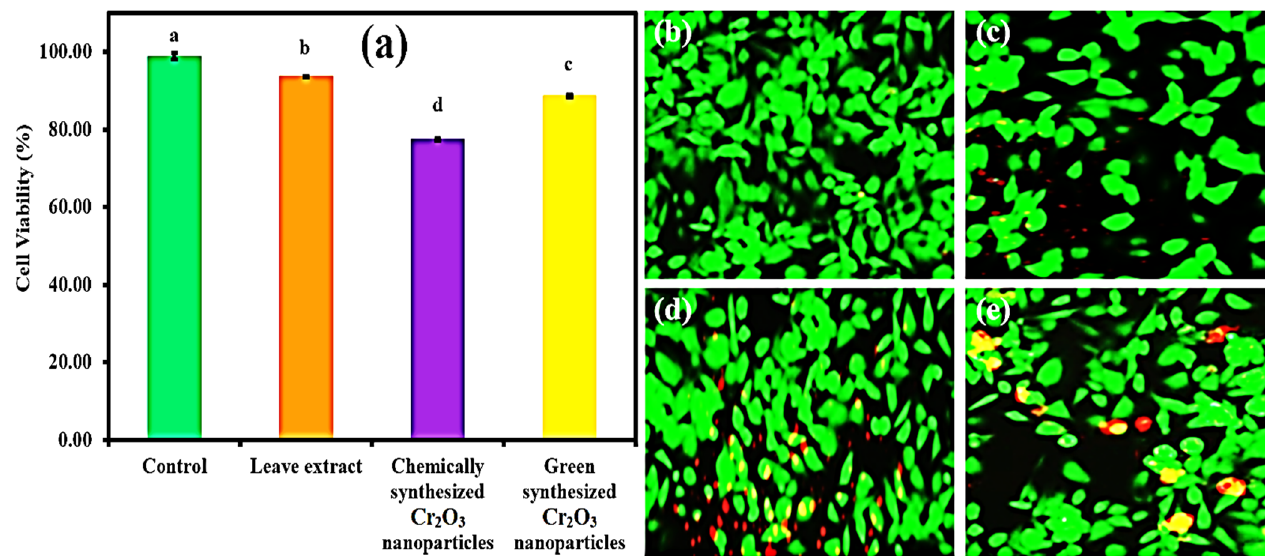
Figure 9. ( a ) The cytobiocompatibility analysis of green synthesized Cr 2 O 3 nanoparticles against Vero cell lines compared to plant extract and chemically synthesized Cr 2 O 3 nanoparticles. (Note: Tukey based heterogeneous lower-case letters represent significant pairs). CLSM images of ( b ) untreated Vero cell lines (control), and treated with ( c ) plant extract, ( d ) chemically synthesized Cr 2 O 3 , and ( e ) green synthesized Cr 2 O 3 nanoparticles (Live cells with green and dead cells with red) (Scale bar = 50 µm).